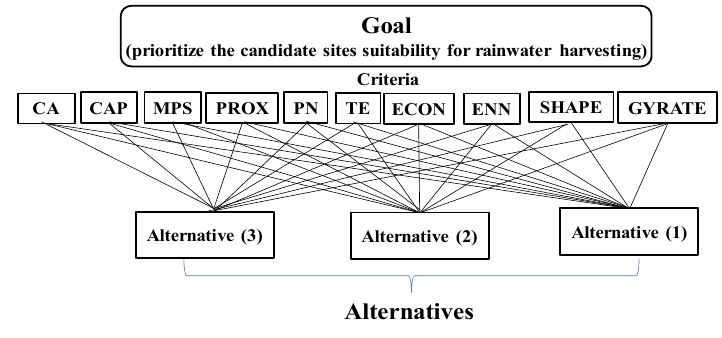
Figure 3. The AHP